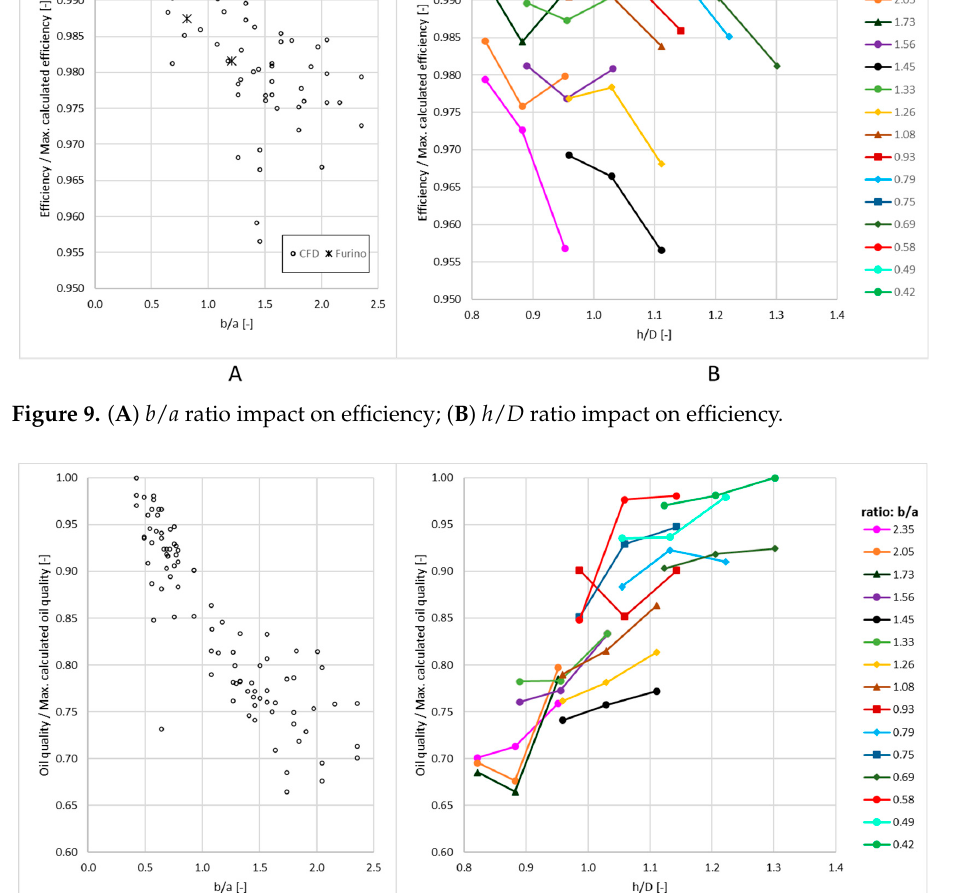
Figure 10. ( A ) b / a ratio impact on the oil quality; ( B ) h / D ratio impact on the oil quality. Analysing the pressure drop for the AAOS (Figure 11), two high values of the pa- rameter were found in the entire range under consideration. The relative pressure drop reached as much as about 0.74 for 𝑏/𝑎 = 0.58 , and the maximum value for 𝑏/𝑎 = 1.73 (Figure 11A). The smallest relative pressure drop occurred for 𝑏/𝑎 = 0.69 at ℎ/𝐷 = 1.2 . For constant values of the 𝑏/𝑎 ratio, the pressure rises with a rise in the value of ℎ/𝐷 . For the range of 𝑏/𝑎 (cid:3408) 1.56 , the relative pressure drop value varied by about 0.1 and be- low the change, totalled about 0.05– 0.07 (Figure 11B).